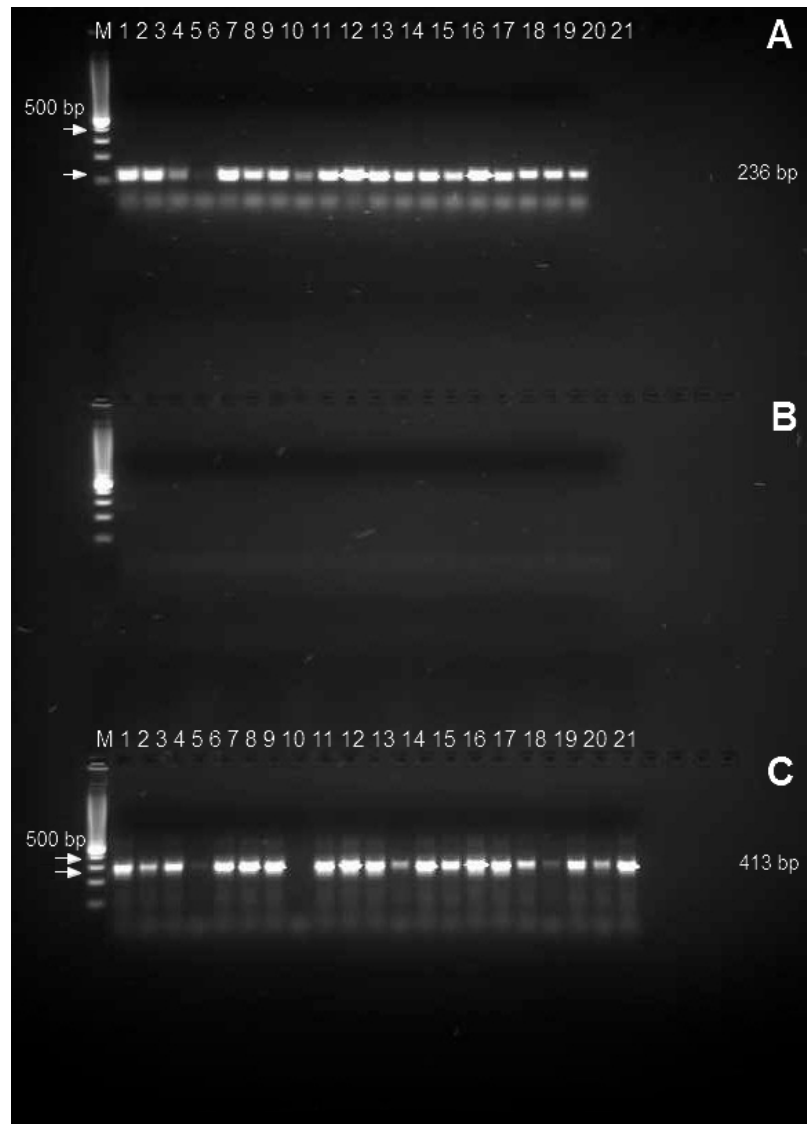
Figure 7. PCR amplicons obtained using primer pairs developed for the aflP ( omtA ) and aflA genes in 21 Aspergillus flavus (Lane1–21) tested with aflP primers ( A ), and an Aspergillus related isolate such as two isolates for both of Aspergillus clavatus, Aspergillus ochraceous, Aspergillus niveus, Aspergillus terreus, Aspergillus fumigatus, Aspergillus versicolor, Penicillium paneum , Penicillium expansum , Penicillium citrinum, Penicillium verrucosum and one Alternaria alternate isolate (Lane 1–21) tested with aflP primers ( B ). A total of 21 Aspergillus flavus (Lane1–21) tested with aflA primers ( C ).